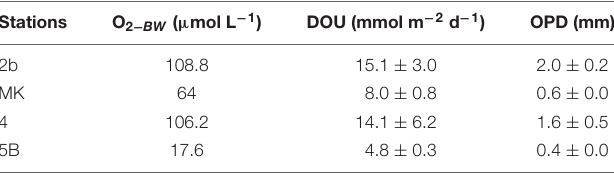
TABLE 2 | Oxygen concentration in bottom water (O 2 BW ), diffusive oxygen uptake (DOU), and oxygen penetration depth (OPD) at the Louisiana shelf in July-August 2017.